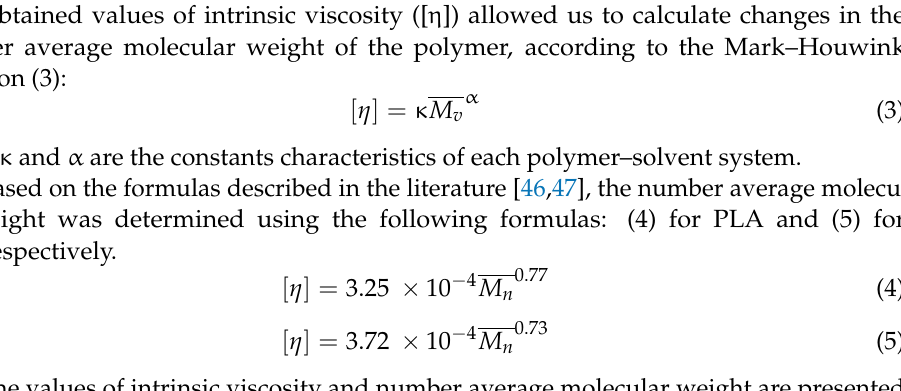
Figure 4. Reduced viscosity η sp /c versus ( a ) PLA and ( b ) PET concentration, before and after the incubation of the polymer in medium (PLA/PET − medium) or in fungal culture (PLA/PET − T. viride).